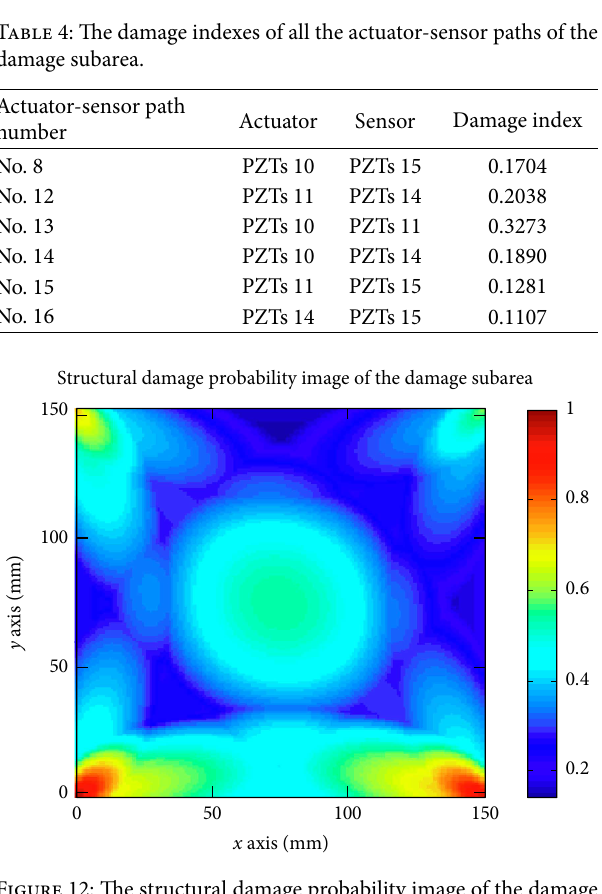
Figure 12: The structural damage probability image of the damage subarea. Table 5: Damage localization results for all